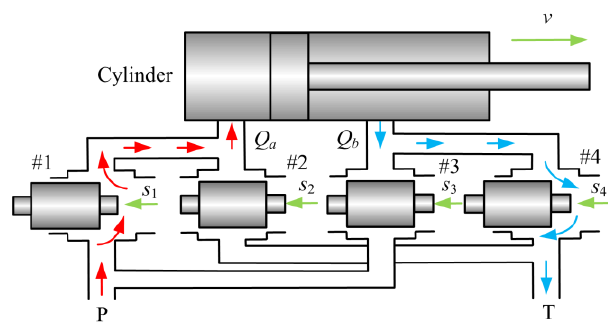
Figure 2. Principle of an independent metering control system.